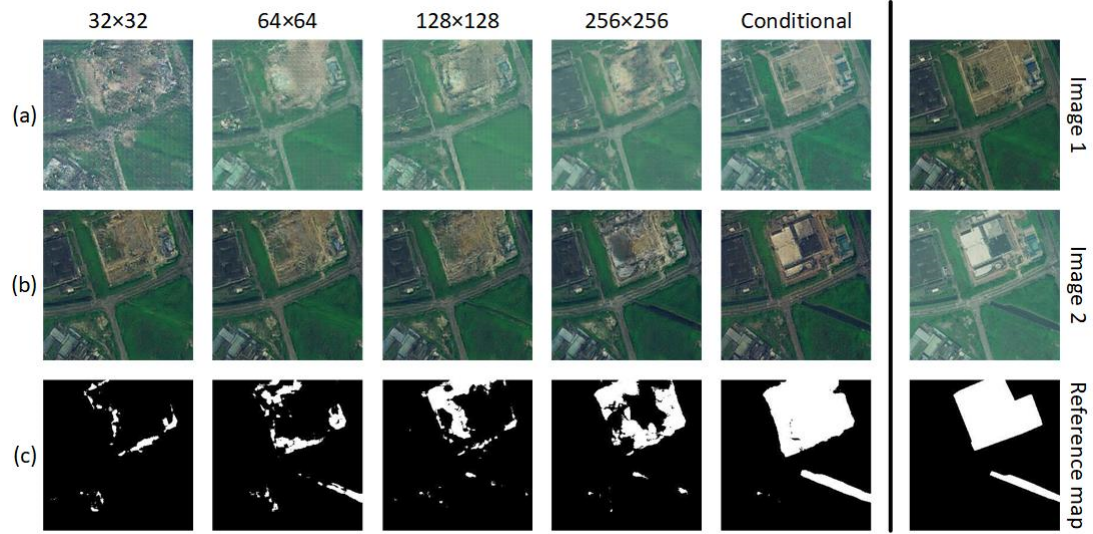
Figure 10. The representative domain transfer results affected by diverse discriminators: ( a ) the fake image translated from domain T 1 to T 2 , ( b ) the fake image translated from domain T 2 to T 1 , ( c ) change detection results.